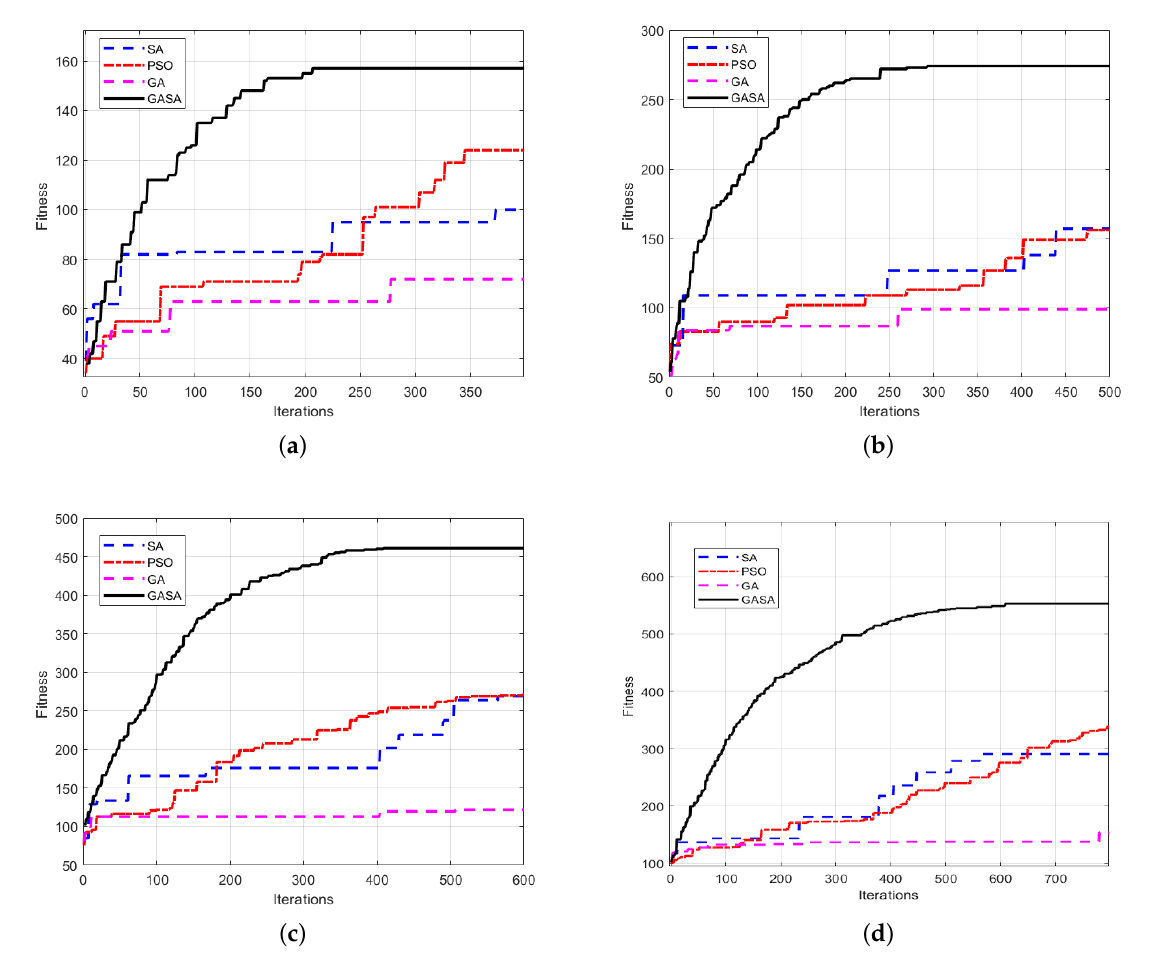
Figure 9. The evolutionary curves of the comparison algorithms: ( a ) The evolutionary curves of 25 tasks. ( b ) The evolutionary curves of 50 tasks. ( c ) The evolutionary curves of 75 tasks. ( d ) The evolutionary curves of 100 tasks.